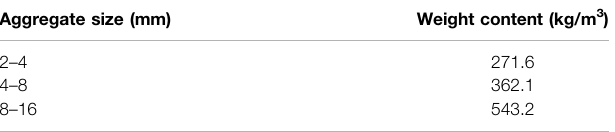
TABLE 3 | Proportion of the coarse aggregates in the concrete substrate.